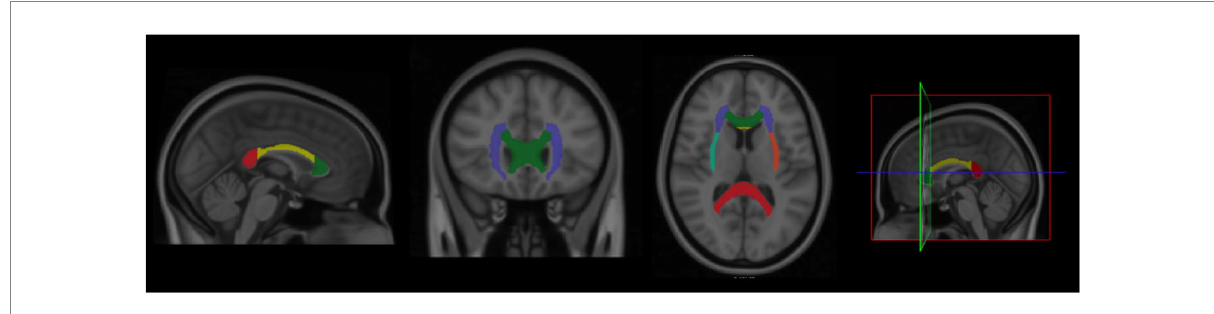
FIGURE 1 The selection of regions of interests